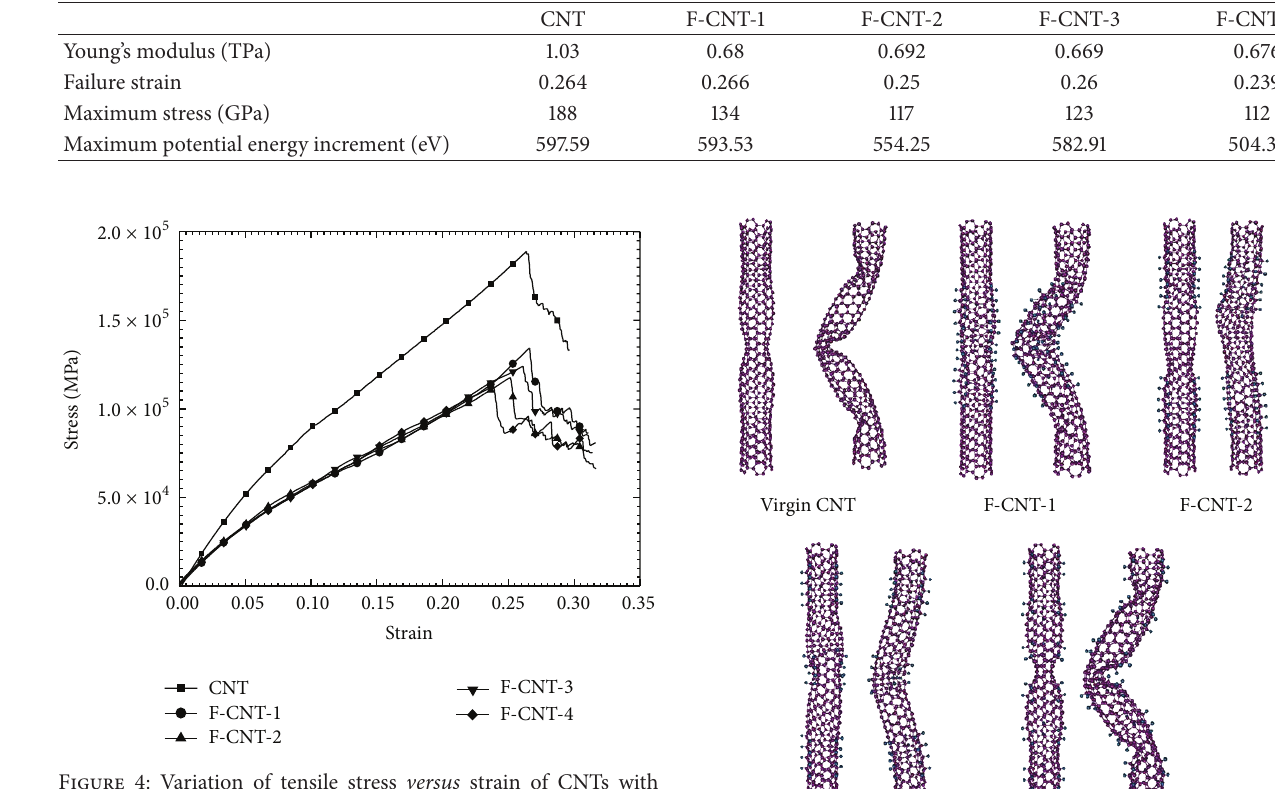
Figure 4: Variation of tensile stress versus strain of CNTs with different functionalization configurations.